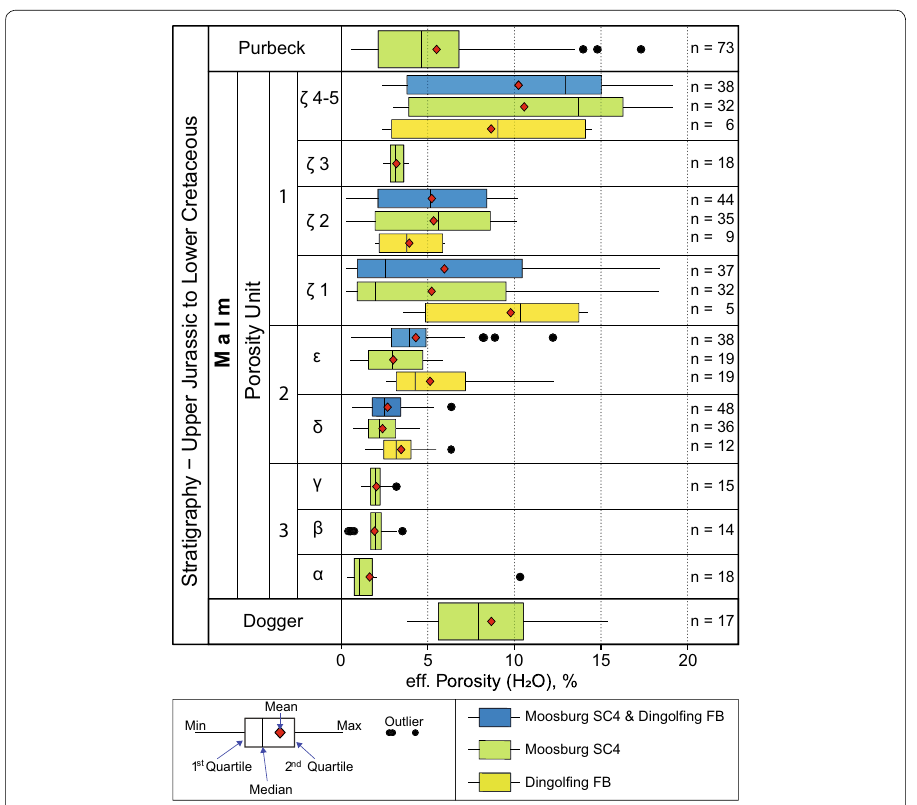
Fig. 5 Boxplots show the distribution of porosity for different stratigraphic Malm units and the classification into superior porosity units. The median porosity for most of the units seems rather low with unimodal distribution. Units Malm ζ 1, ζ 2, and ζ 4–5 overall show higher porosity values and a more